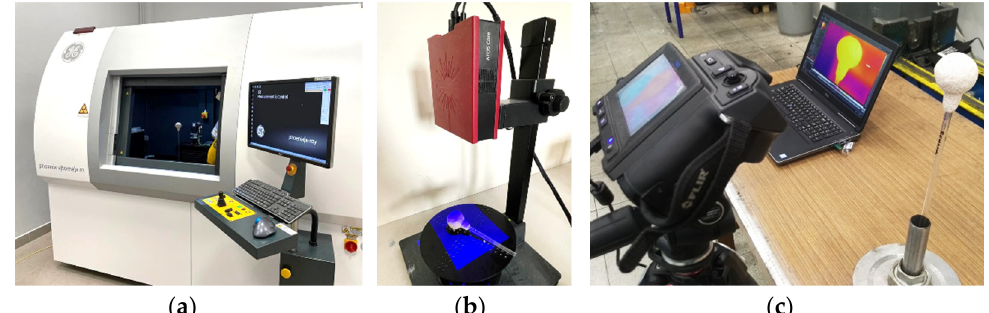
Figure 4. Equipment for NDT testing: computer tomograph Phoenix v|tomex m300 ( a ), GOM ATOS Core 3D scanner ( b ) and Flir T640 thermal imaging camera ( c ).